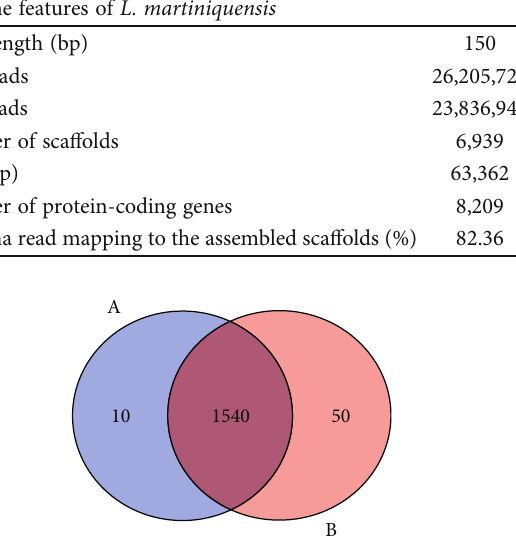
Table 1: Statistics of L. martiniquensis data and de novo assembly. Genome features of L. martiniquensis